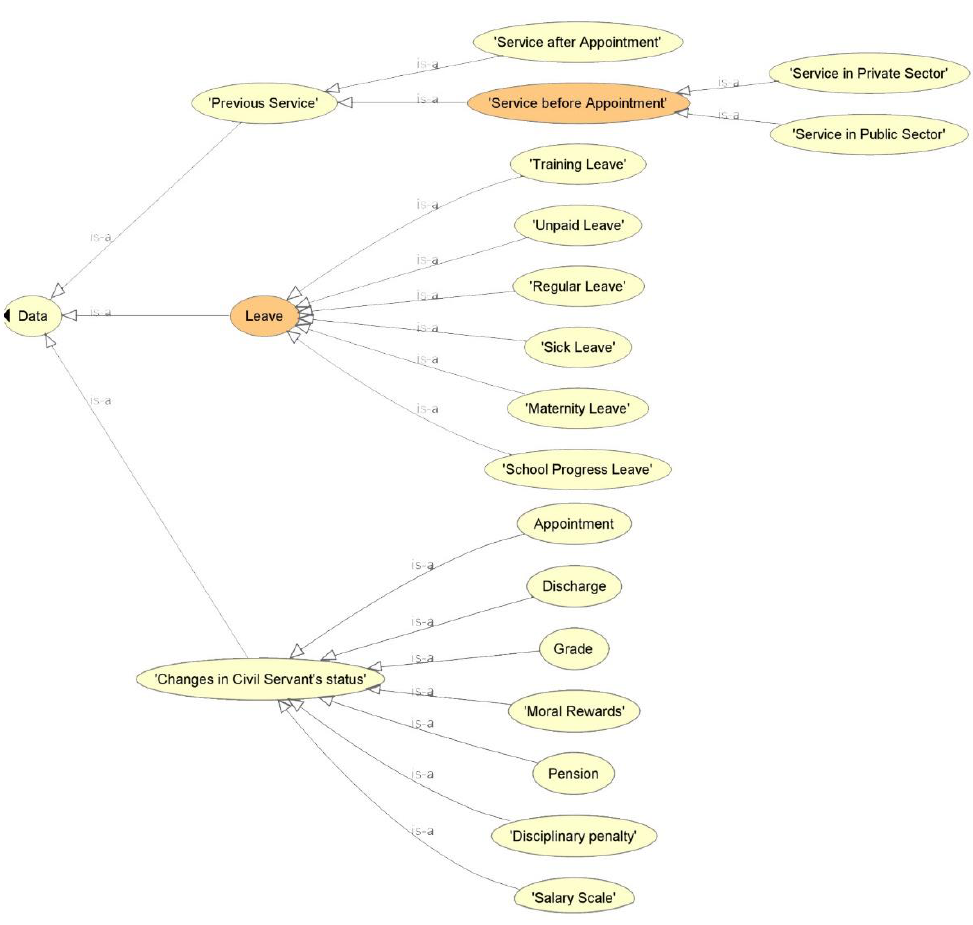
Figure 4. The Data class hierarchy.